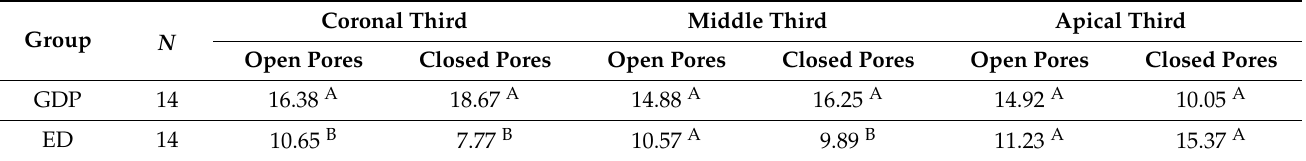
Table 1. Mean ranks of open and closed pores in the coronal, middle, and apical thirds.